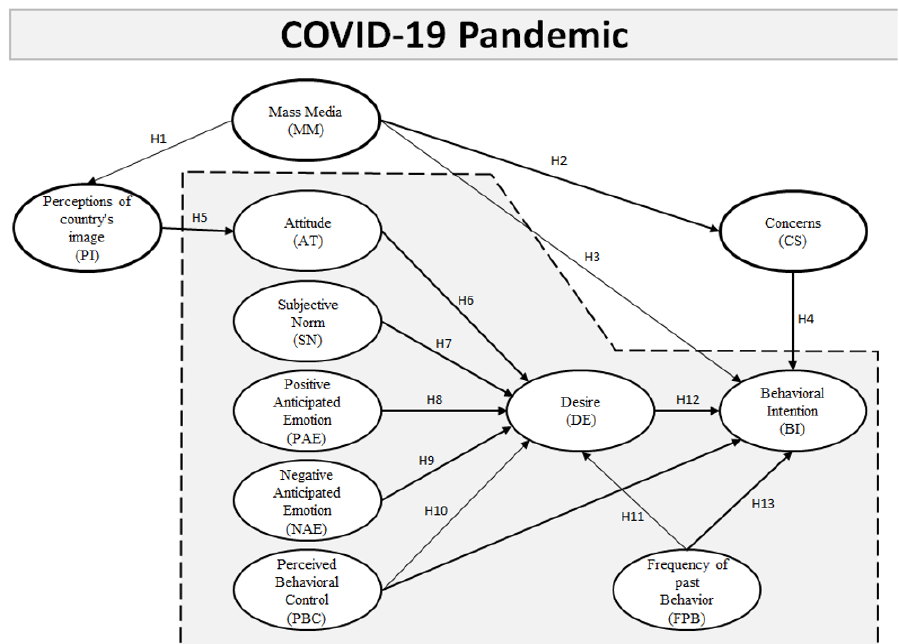
Figure 3. The extended model of goal-directed behaviour (EMGB). Note: The shaded area shows the basic components of the model of goal-directed behaviour (MGB); the three bold ovals are the additional constructs perception of country image (PCI), mass media (MM), and CS that contribute to developing the EMGB. (Note: H1–H13 are hypothesis of this